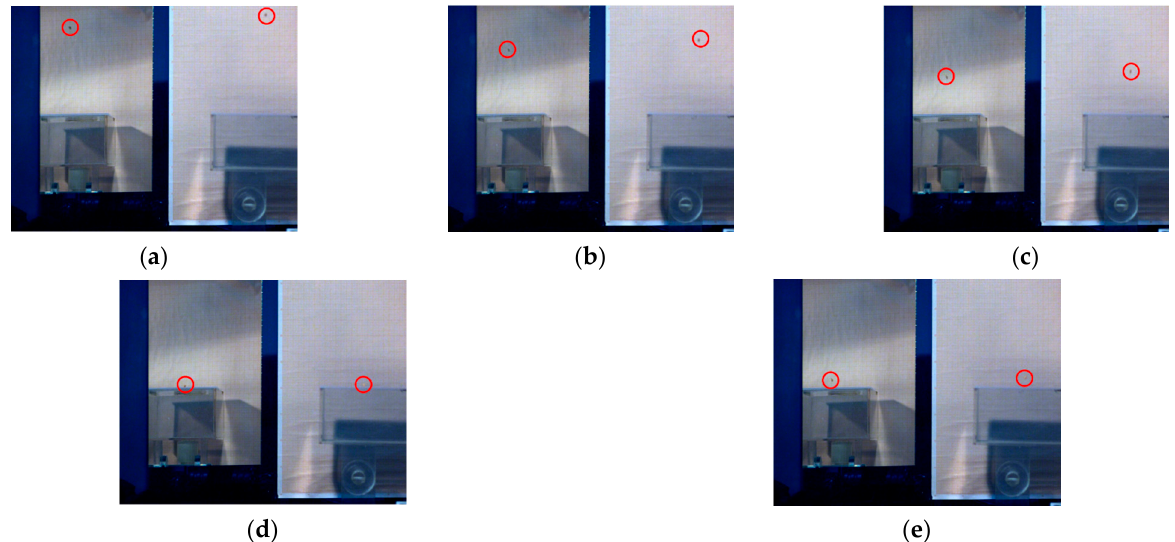
Figure 9. Rice grain bouncing state of bench test. The picture shows the falling state of grains at different times: ( a ) 0.01 s; ( b ) 0.04 s; ( c ) 0.07 s; ( d ) 0.10 s; and ( e ) 0.13 s.